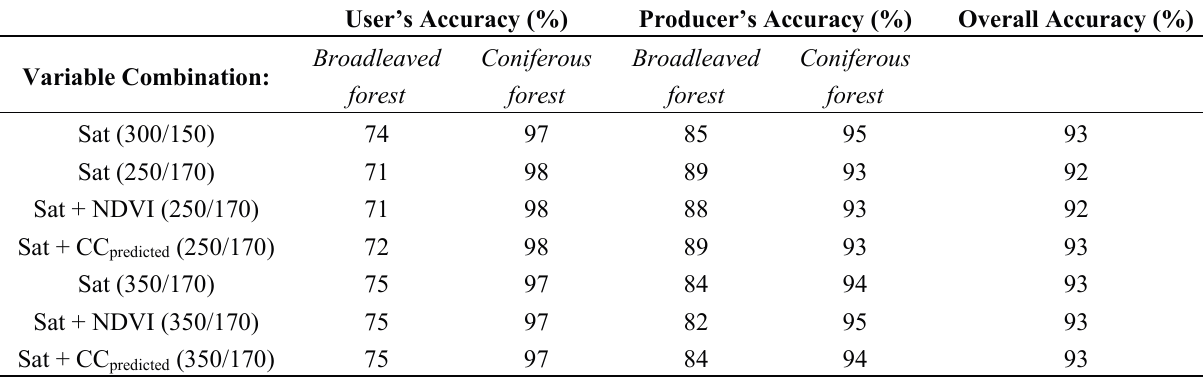
Table 2. Accuracy for Random Forest classification of broadleaved or coniferous species dominated forest in the tree covered stratum, using different independent variables and training data. Sat means optical satellite data, NDVI is Normalized Differential Vegetation Index, and Canopy Cover (CC) is predicted from cross validation in the regression models. The numbers in the variable combination column indicates the number of reference data plots (no. coniferous/no. broadleaved) drawn for each tree in Random Forest